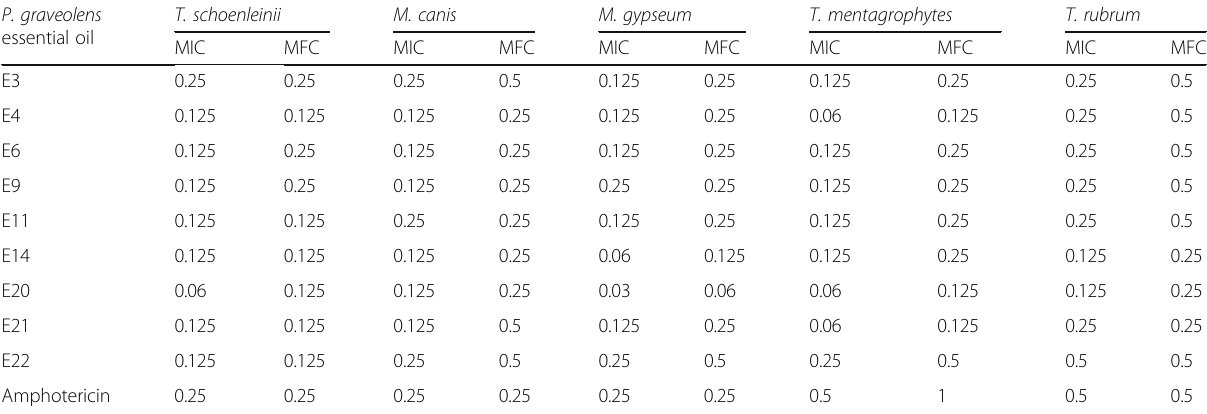
Table 3 The antifungal activity of P. graveolens essential oils against